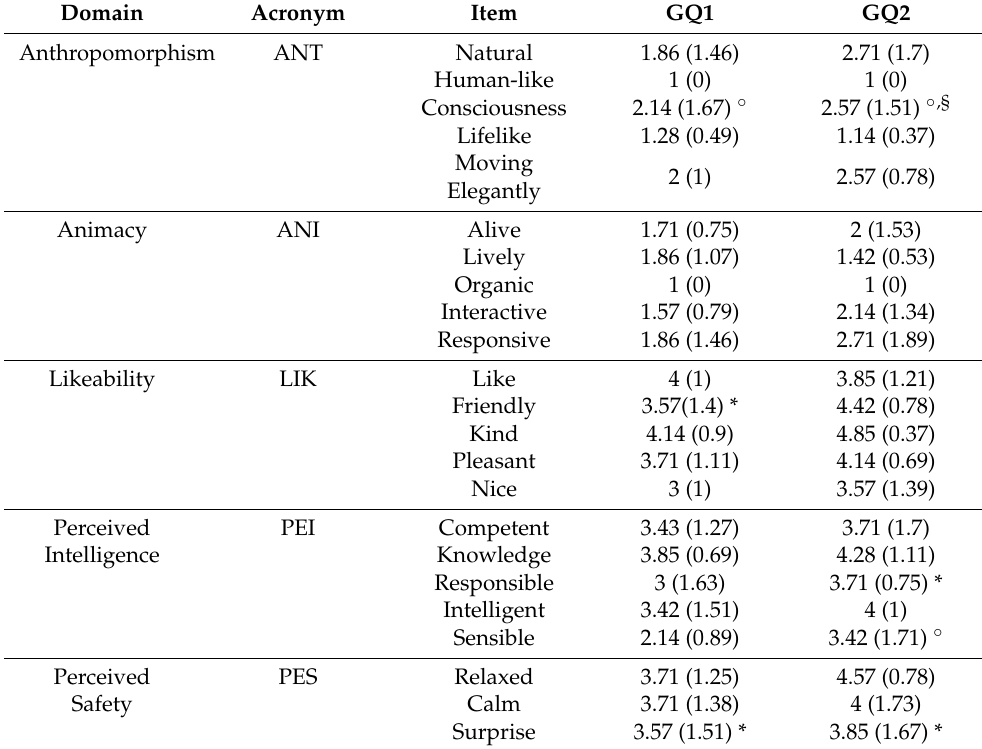
Table 4. The average and the standard deviation of each item of the Godspeed questionnaires, administrated before (GQ1) and after (GQ2) the cognitive